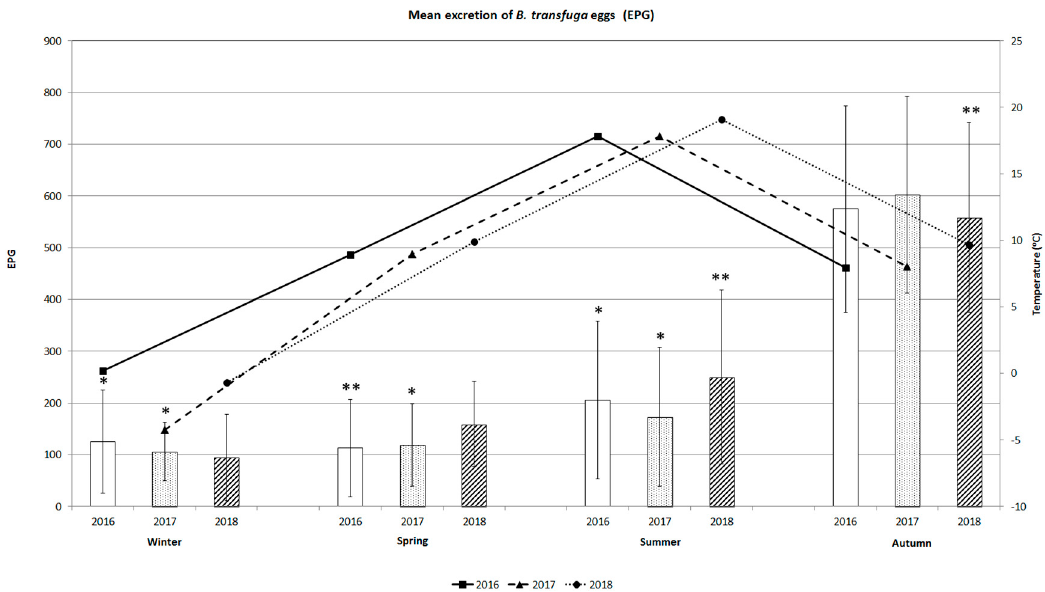
Figure 4. Mean excretion of B. transfuga eggs (EPG) in the brown bear ( Ursus arctos ) and mean temperature (°C) during different seasons of the three-year survey; *, significant differences between autumn, winter, and summer 2016 and between winter, spring, and summer 2017; p < 0.0001; **, significant differences between spring and autumn 2016 and between winter, summer, and autumn 2018, p < 0.00.